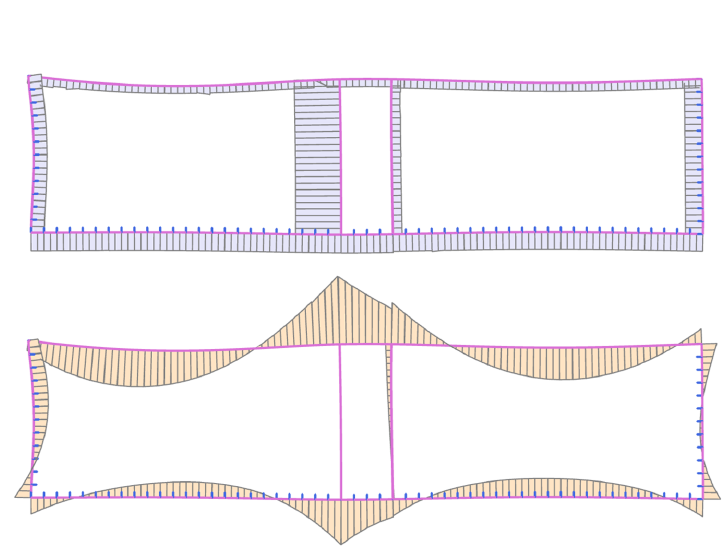
Figure 6. Axial force (top; compression blue) and bending moment (bottom) after 12 hours of fire exposure (end of the fire event